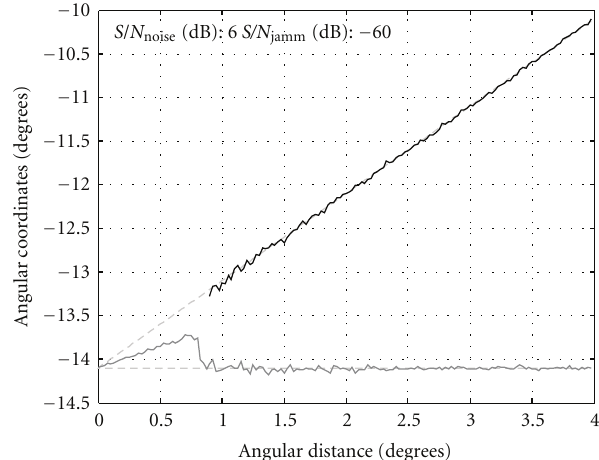
Figure 15: Histogram of polar coordinates evaluated by means of the TLS ESPRIT method at S/N noise = 6dB, S/N jamm = − 60dB, and without initial